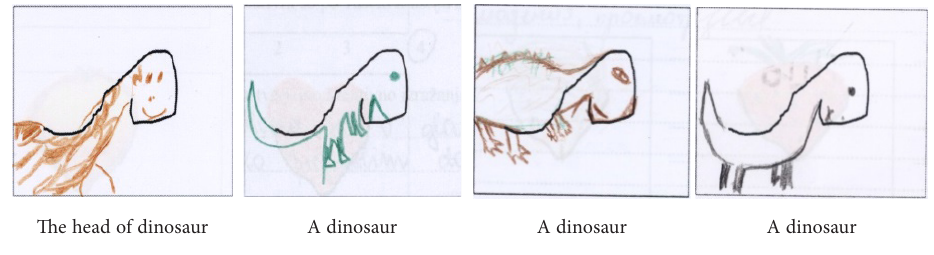
Figure 11. The creative task: interpretation of Fragment 2 – animals: dinosaurs (source: testingmom.com, 2020) The interpretation of the presented fragment employing the animal motif indicates the influence of animated nature on the personal processes of association and interpretation.